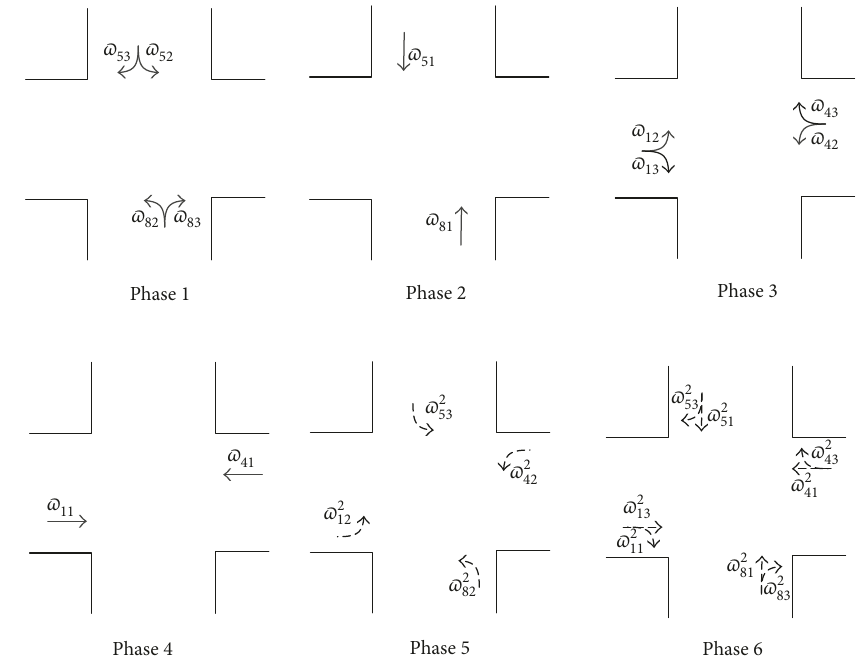
Figure 7: Illustration of control strategy 3 in intersection